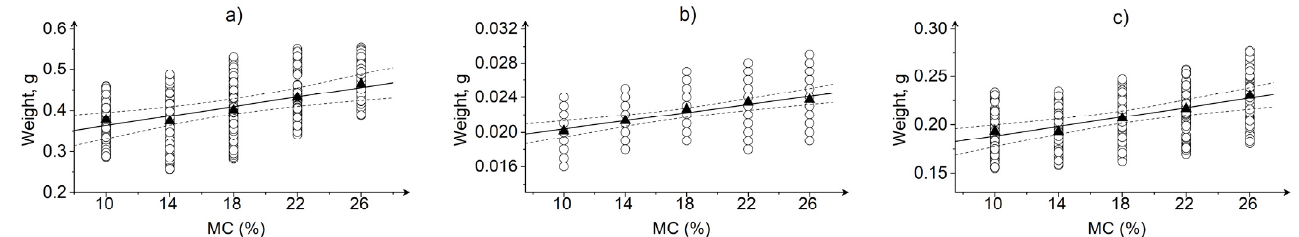
Figure 4. The dependencies between moisture content and weight: ( a ) maize, m = 0.00578 MC + 0.305, R 2 = 0.914, ( b ) rice, m = 0.000233 MC + 0.0180, R 2 = 0.953, ( c ) soybeans, m = 0.00243 MC +